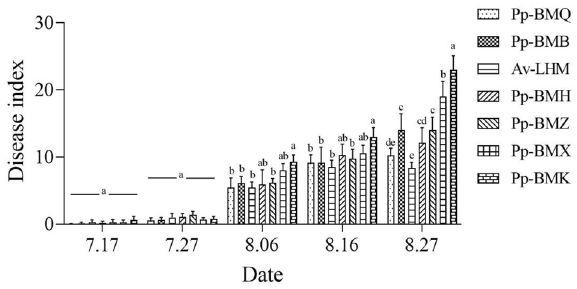
Figure 6. The disease index of seven ecotypes stem necrosis lesions disease caused by B. exigua var. rhapontica in 2020 in the field.